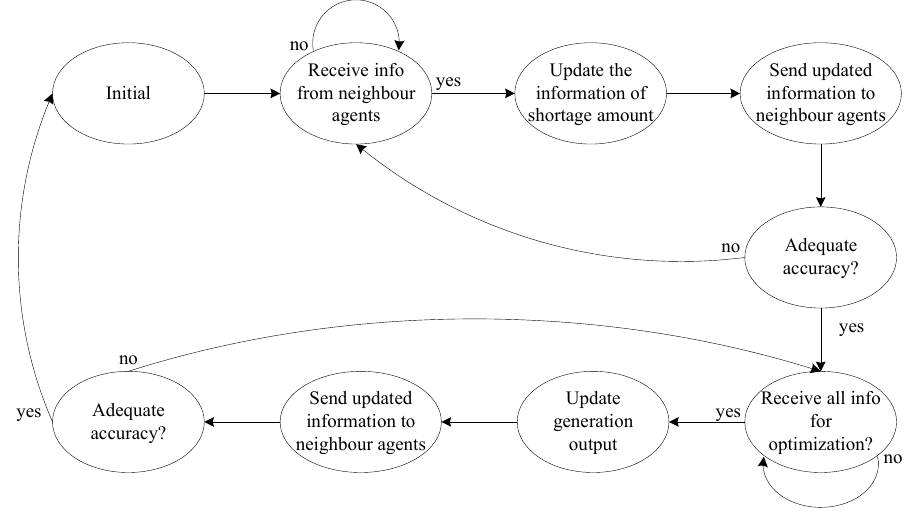
Figure 5. State diagram of each agent in isolated part.